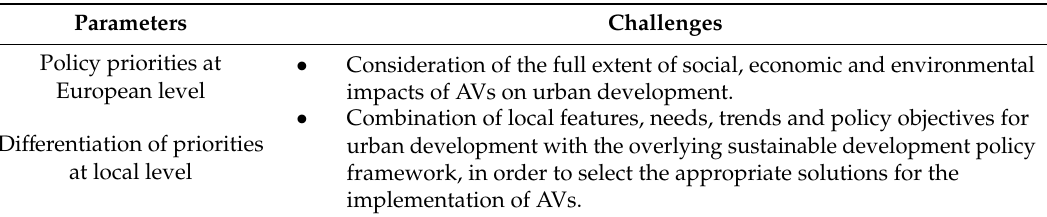
Table 2. Parameters of potential integration of the AV concept with the sustainable urban development policy and relevant challenges for urban planning in